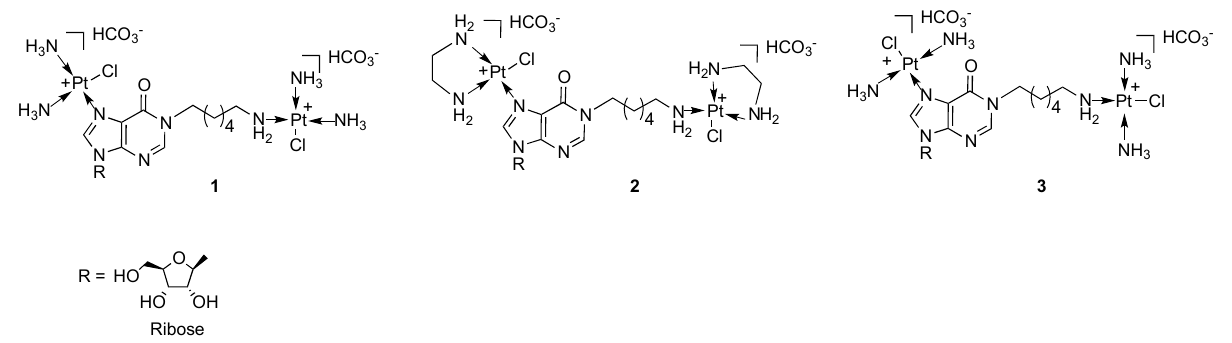
Figure 1. Bis-platinated nucleoside complexes synthesized starting from inosine